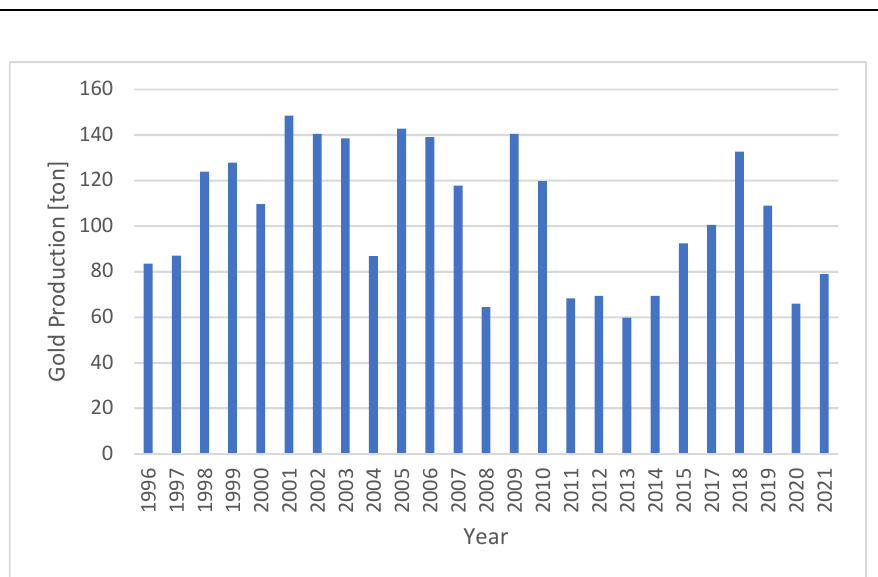
Figure 2 . Indonesian Gold Production (Source: Statistics Indonesia).